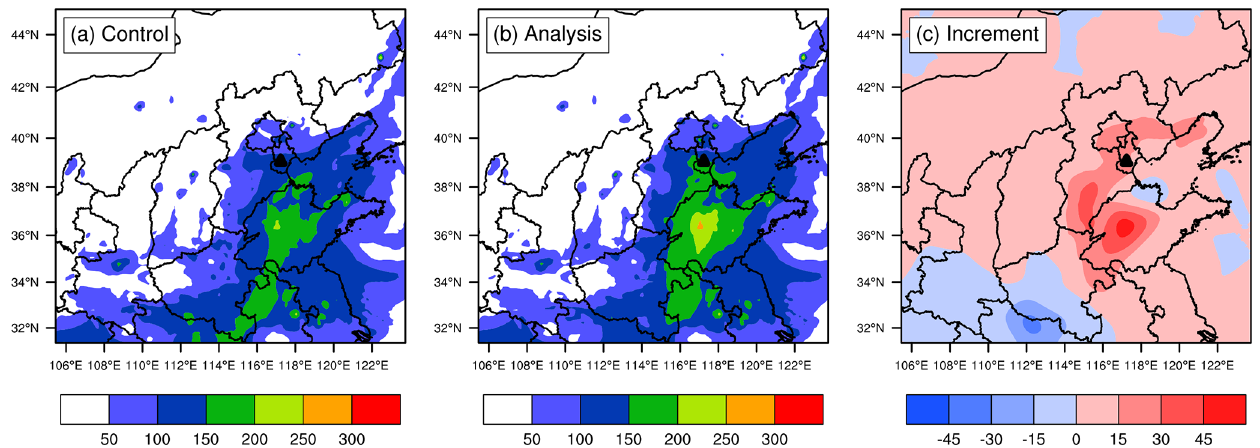
Figure 9. Spatial distribution of surface PM 2 . 5 concentrations simulated at an initialization of 03:00UTC on 25 November 2018 in (a) the control experiment and (b) the assimilation experiment and (c) the increment that is the difference between (b) and (a) . These quantities are in units of µgm − 3 and colocated in D02.